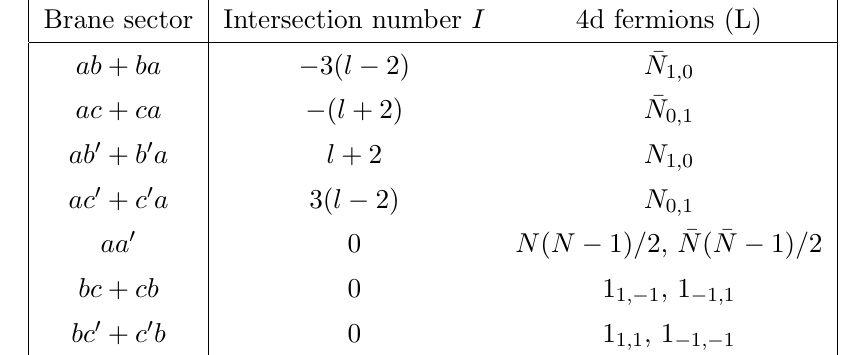
Table 2 . Chiral and vector-like representations of left-handed fermions at various brane intersec-